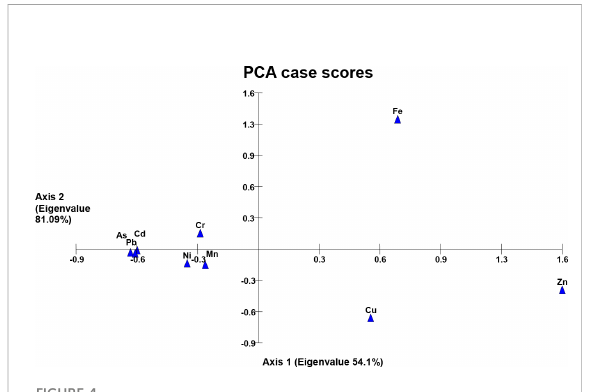
FIGURE 4 Heavy metals in vegetables and crop plants irrigated with